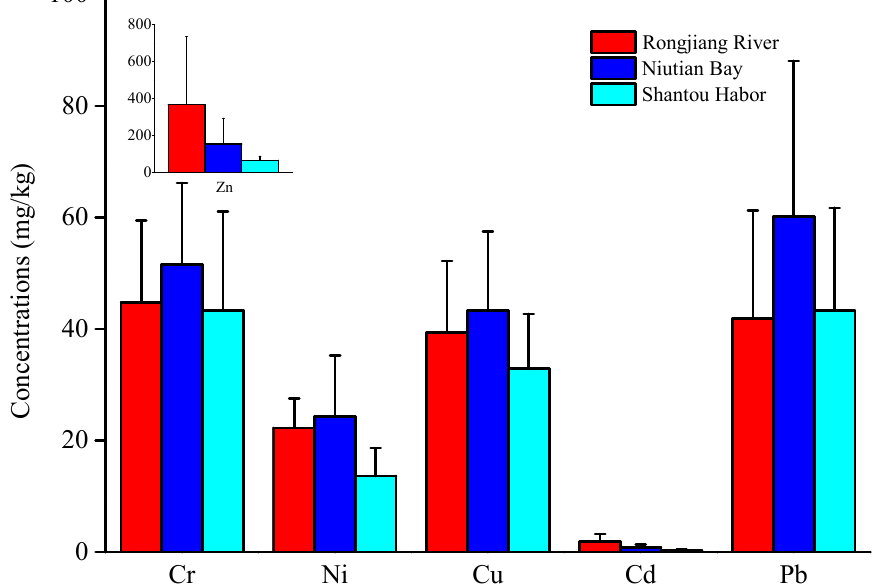
Figure 3. Spatial variations for metal concentrations in sediments of Shantou Bay.